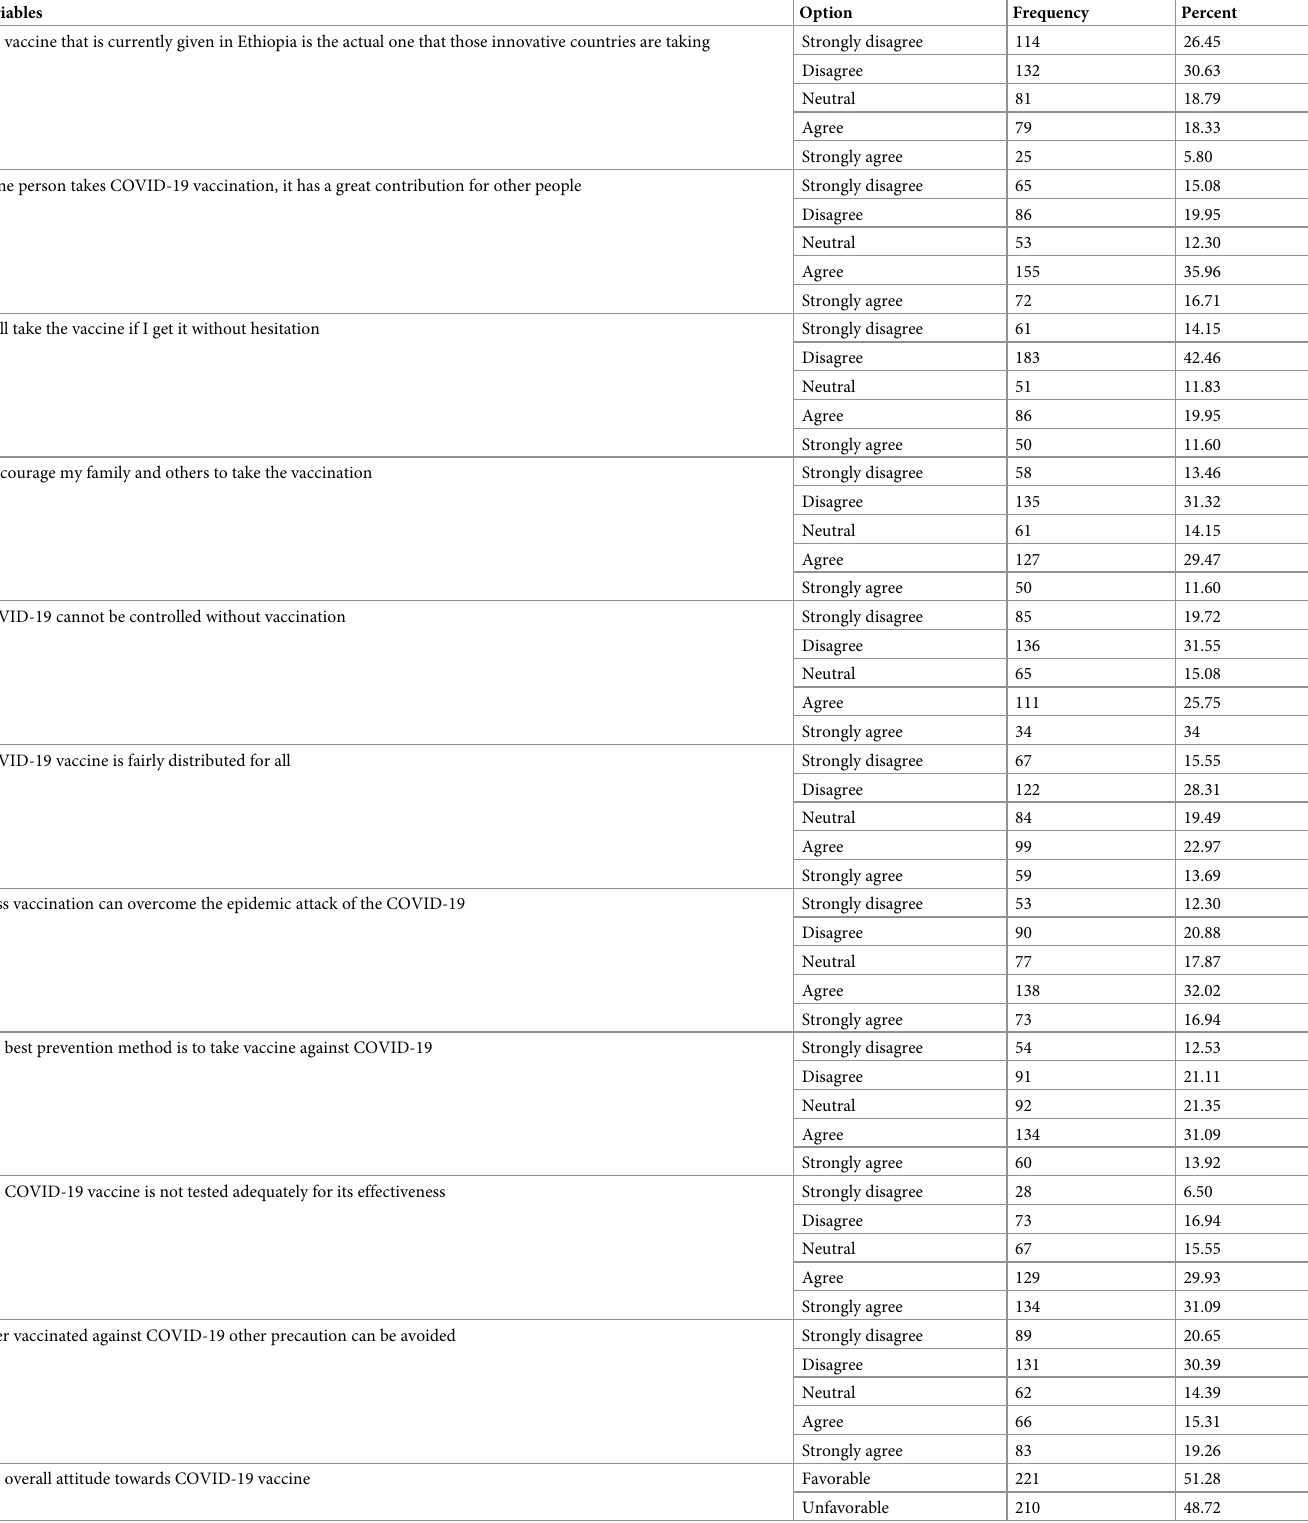
Table 2. Attitude of the health care workers towards COVID-19 vaccine in Nekemte health facilities, Western Ethiopia.